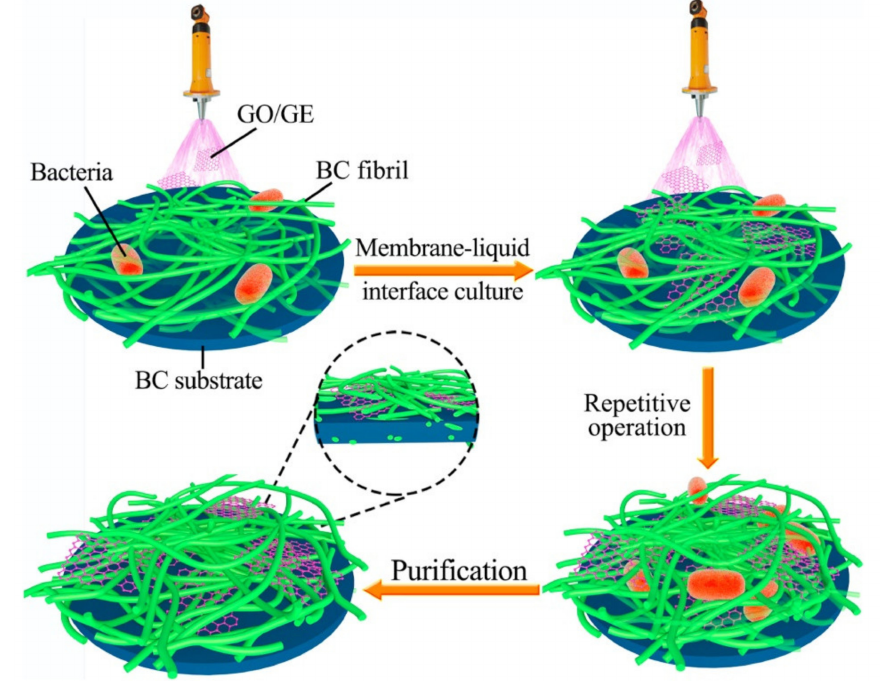
Figure 4. Schematic representation of the steps involved in the MILIC fabrication method used for the GO / BC and GE / BC sca ff olds [87]. Reproduced with copyright